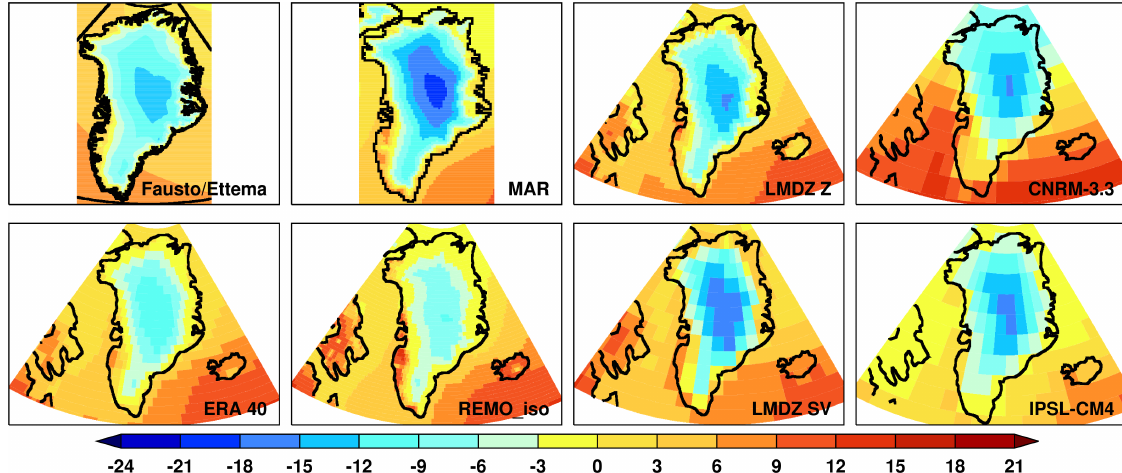
Fig. 3. Climatological (1980-1999) June-July-August mean 2 m temperature in the eight different climate models (in ◦ C).